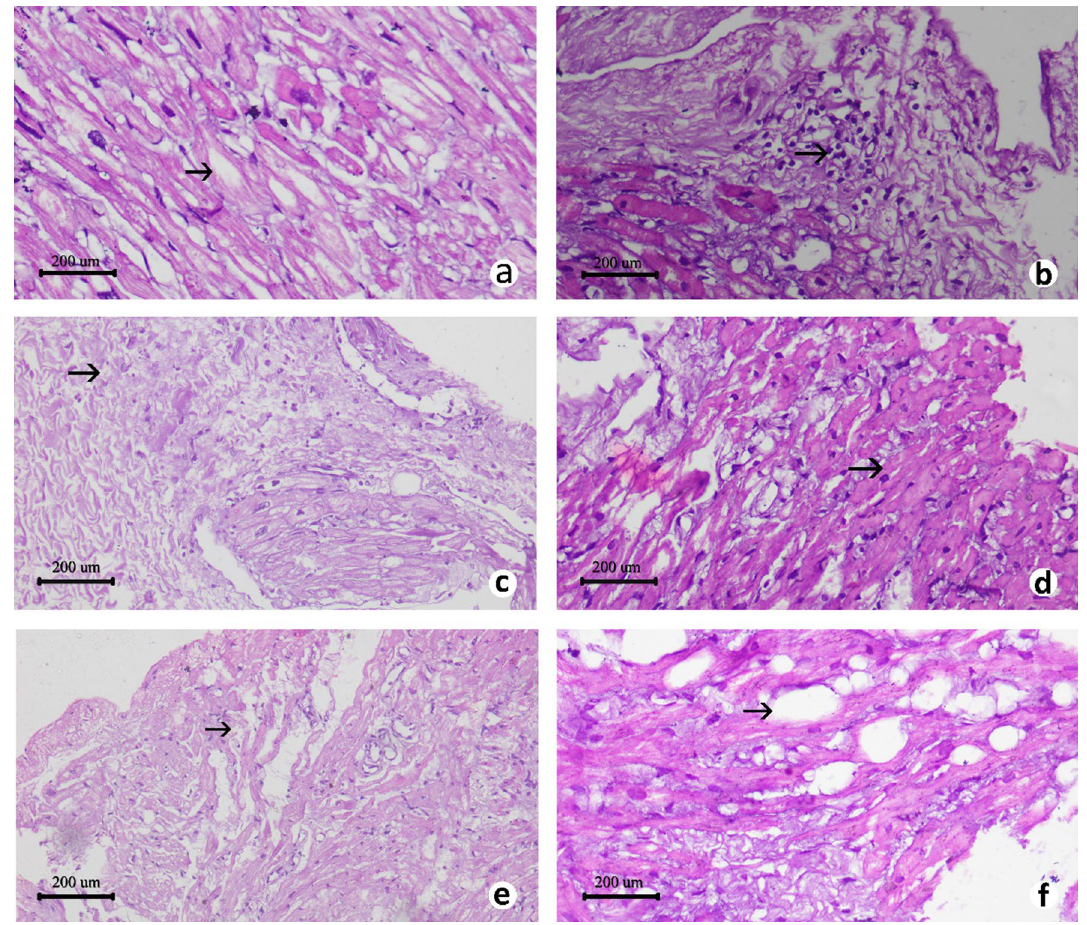
Figure 3. Histopathology images of cardiac tissue of patients. Representative photomicrographs (H and E stain) of cardiac tissue histopathology of patients showing different parameters; ( a ) edema (40x); ( b ) leukocyte infiltration (40x); ( c ) fibrosis (10x); ( d ) myocardial fiber swelling (40x); ( e ) fiber separation (10x); ( f ) fatty change (40x). The default scale bar for each micrograph was set at 200